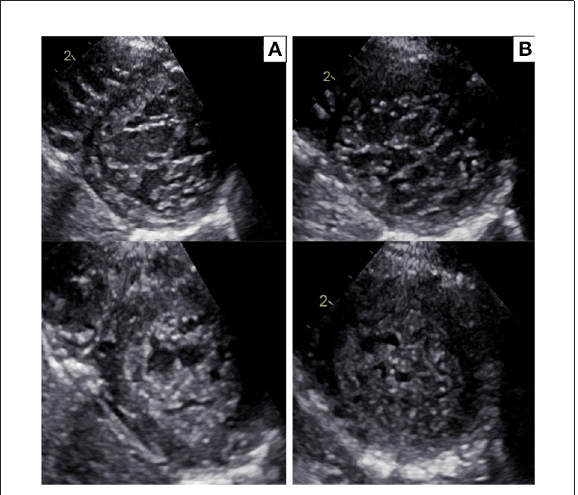
FIGURE2 (A) Echocardiographic parasternal short-axis view in the proband: diastole (upper panel) and systole (bottom panel). Trabecular/compacted end-systolic wall thickness ratio > 2 (positive Jenni criteria for LVNC). (B) Echocardiographic parasternal short-axis view in the sister of the proband: diastole (upper panel) and systole (bottom panel). Trabecular/compacted end-systolic wall thickness ratio > 2 (positive Jenni criteria for LVNC).